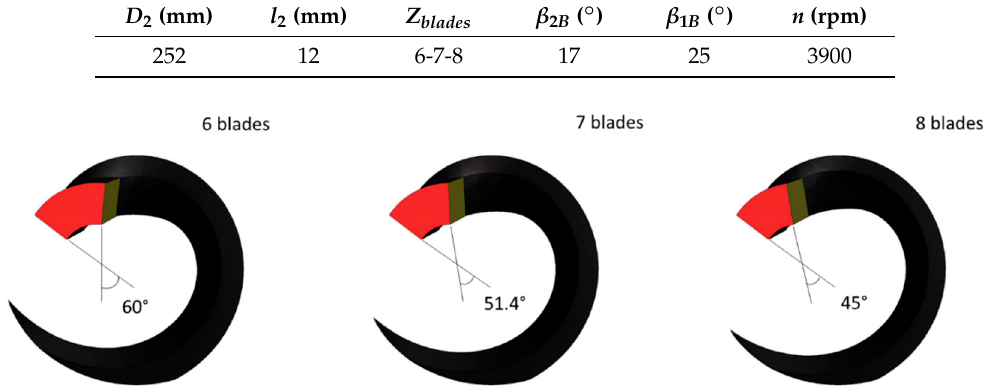
Figure 3. Three single vane geometries of the selected centrifugal pump with different number of blades.